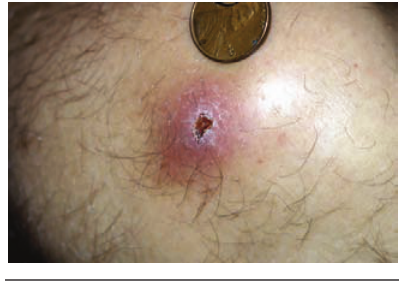
Figure 1. An erythematous nodule with central scabbing over the left knee.